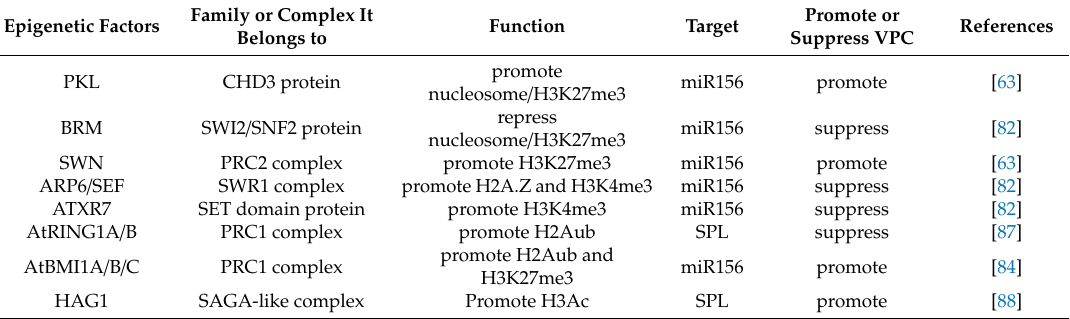
Table 1. Epigenetic factors regulating vegetative phase change